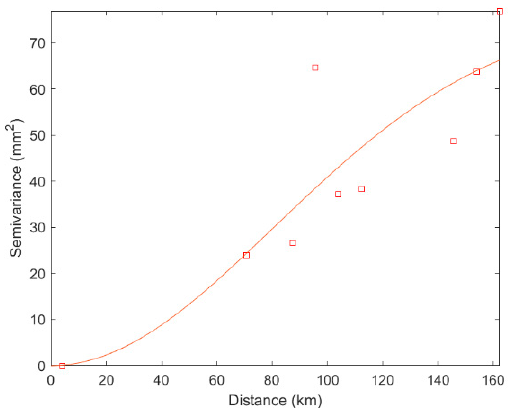
Figure 3. Sample variogram for the sparse network (square symbols) with fitted model (solid curve).